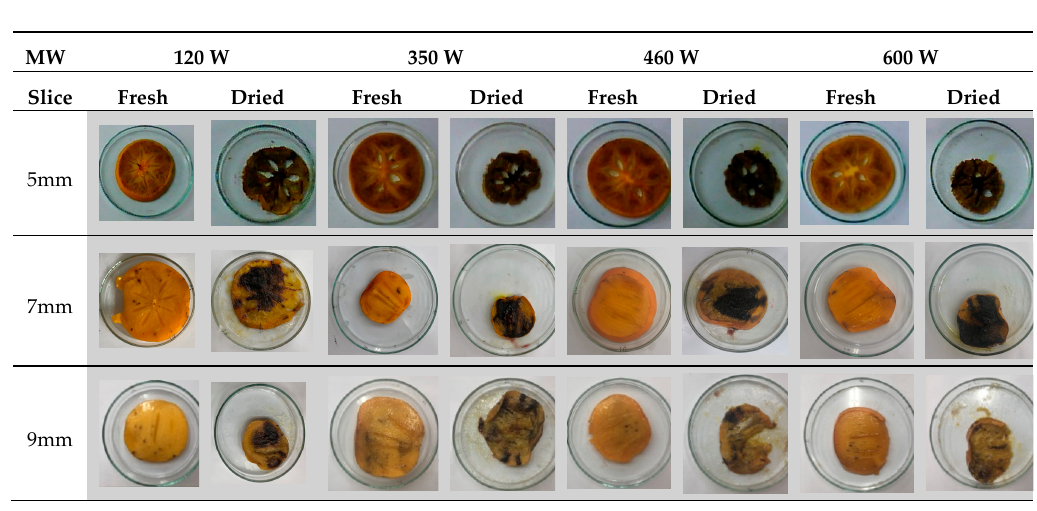
Table 3. Color parameter results.